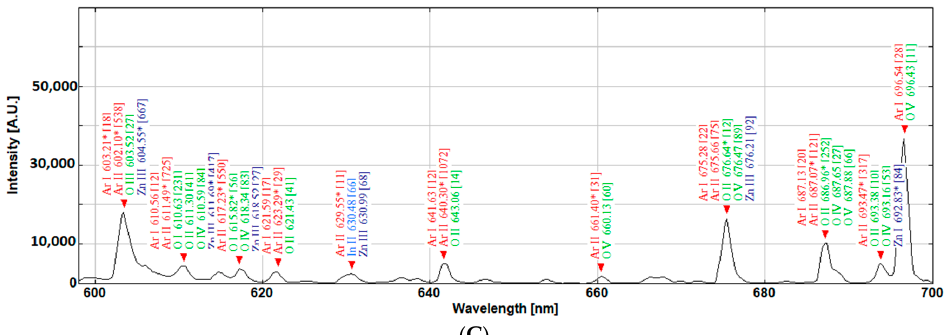
Figure 13. The emission spectrum and the associated Argon, Indium, Zinc, and Oxygen states within the 400–700 nm section of the spectrum obtained from the sputtering plasma. These are the areas (including the unmarked peaks) used for calculating the colour coordinates by measuring the area under the peaks as discusses earlier and elaborated in Figure 1. Spectral range, ( A ): 400–500 nm, ( B ) 500–600 nm, ( C ): 600–700 nm.